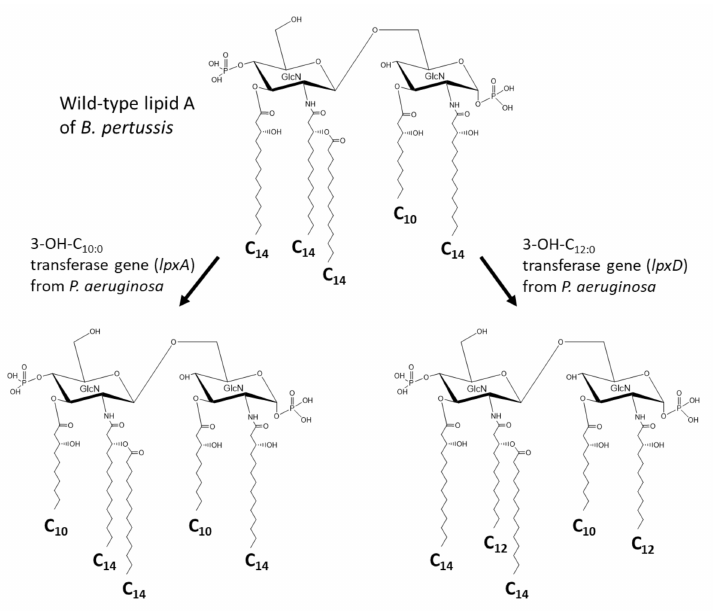
Figure 7. Engineering of Bordetella pertussis lipid A using acyltransferase genes from Pseu- domonas aeruginosa